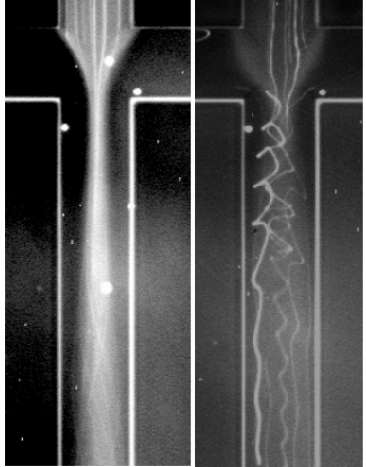
Figure 25. Particle trajectories with static (left-hand-side photo) and time-varying (right-hand-side photo) electric fields at the inlet of the channel (from Shin et al.